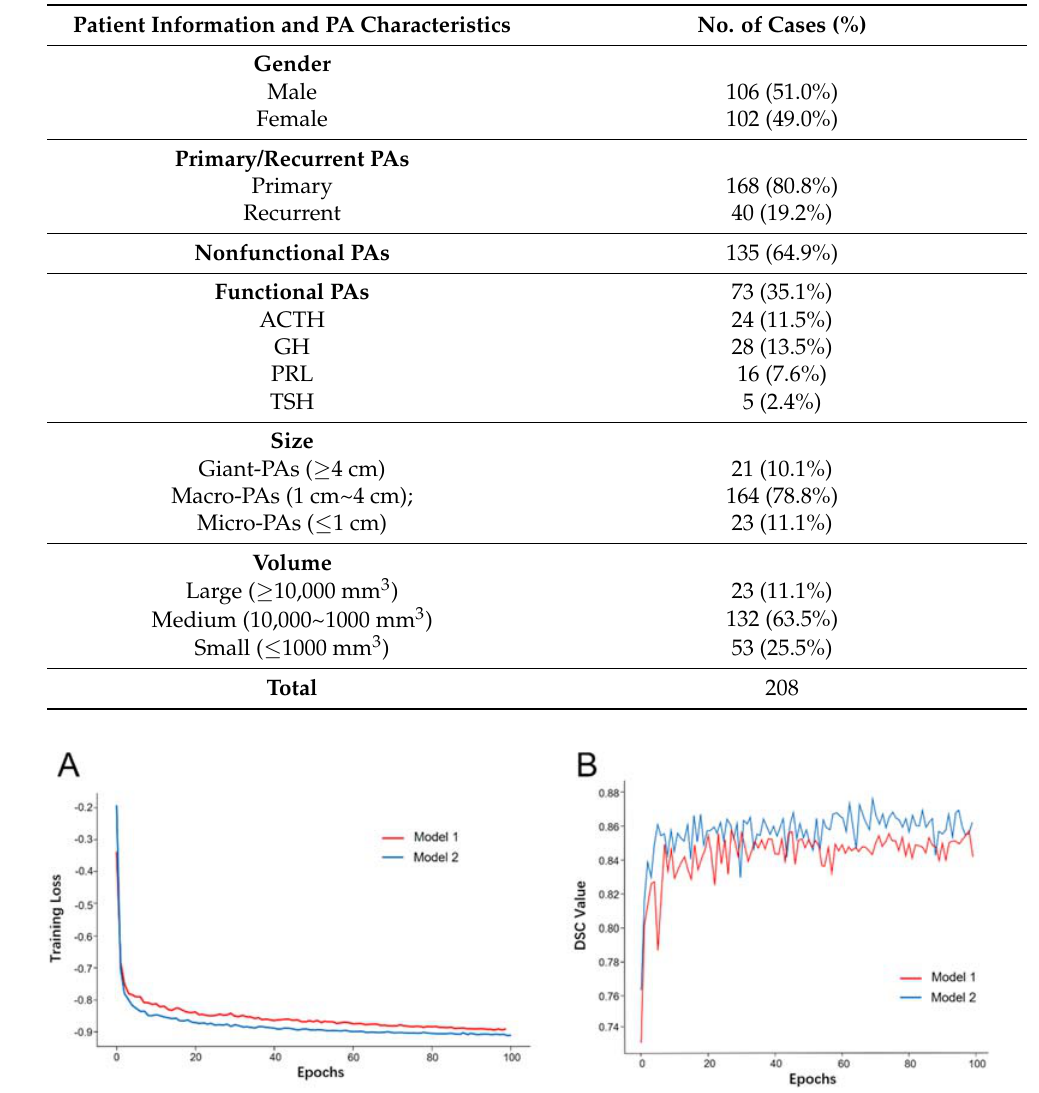
Figure 3. Loss curve of the training process for Models 1 and 2 ( A ). Evaluation metric curve of the training process for Models 1 and 2 ( B ).